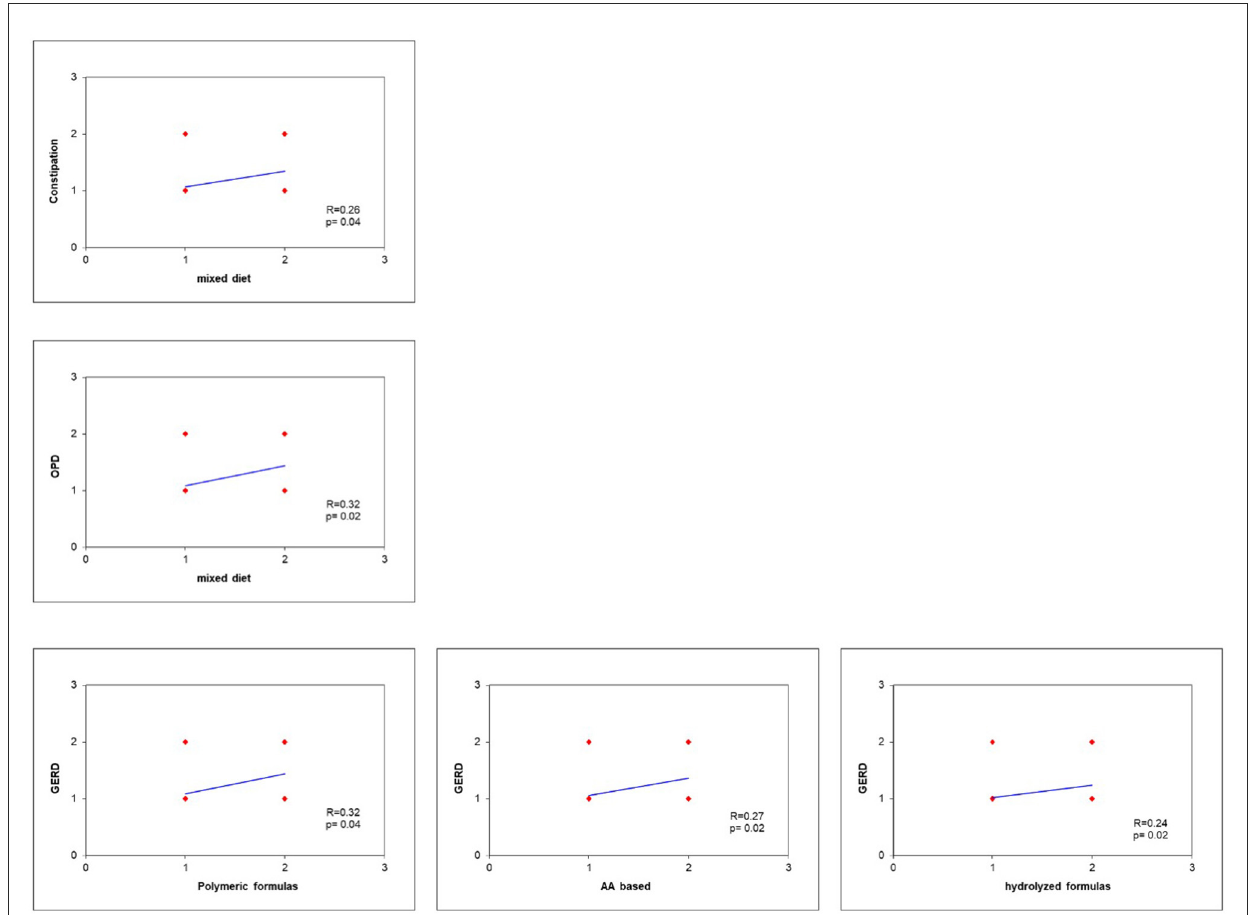
FIGURE2 GERD results correlate with EN formula ( p = 0.03), but not with mixed diet ( p = 0.05). Polymeric formulas showed the highest correlation with GERD ( R = 0.32), followed by AA based ( R = 0.27) and hydrolyzed formulas ( R = 0.24). Constipation and OPD were significantly correlated with mixed diet ( p = 0.04, R = 0.26, and p = 0.02, R = 0.32,